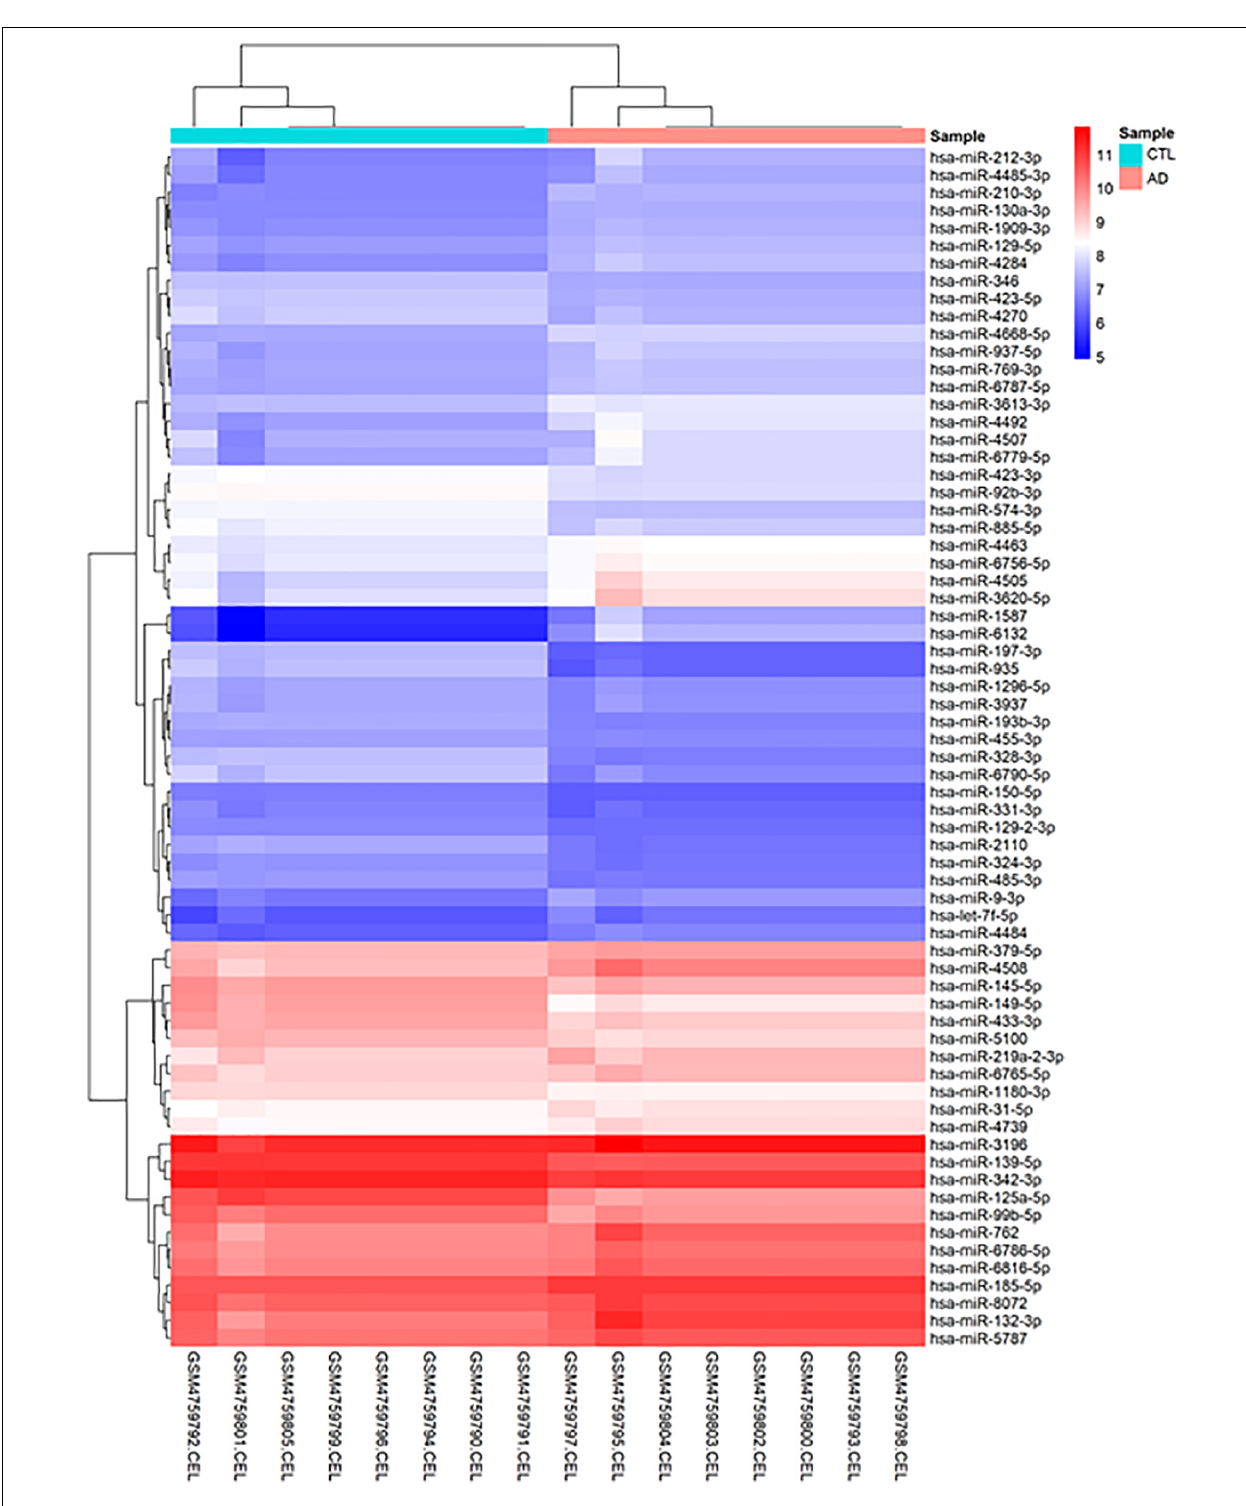
Frontiers in Aging Neuroscience |